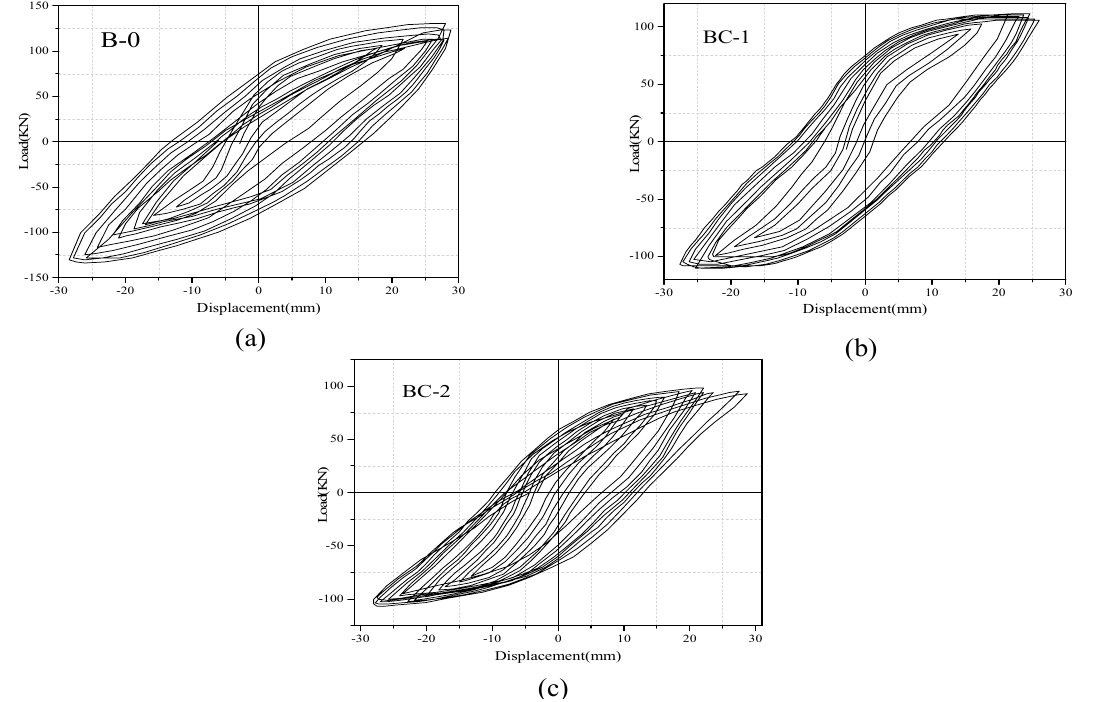
Figure 7. Hysteretic curve of tested specimens: ( a ) solid beam, B-0, ( b ) beam with opening in shear zone, BC-1, ( c ) beam with opening in flexural zone, BC-2.